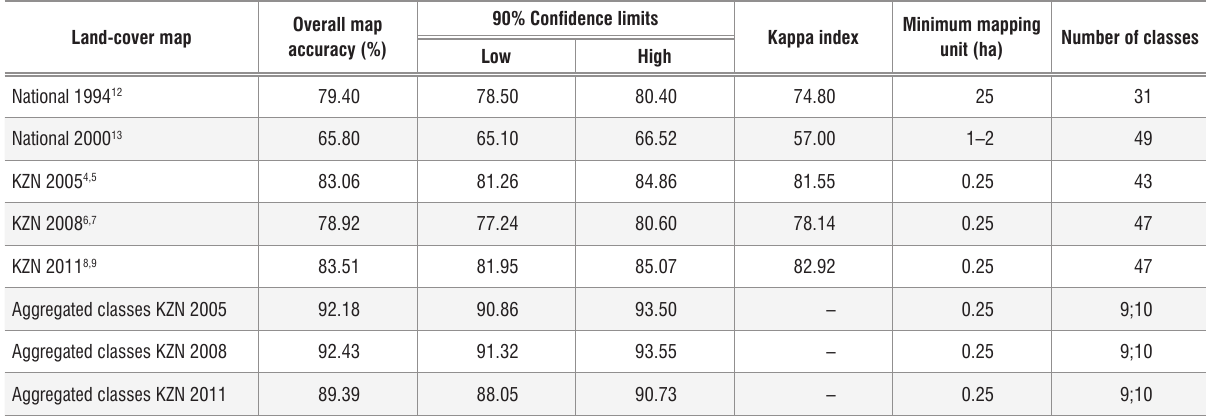
Land-cover map accuracy statistics, minimum mapping unit and number of classes for the national, KwaZulu-Natal (KZN) and aggregated class KZN land-cover maps. Initially nine categories were used in the analysis using the aggregated class maps, whereafter an ‘abandoned’ category was added and used in the Intensity